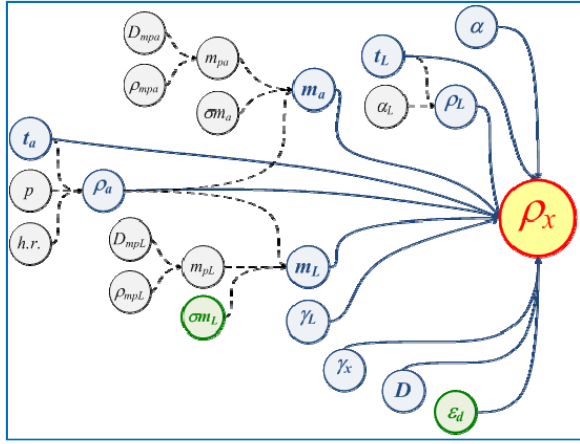
Figure 11. Tree diagram of the uncertainty contributions in the calibration of immersion hydrometers by Cuckow’s